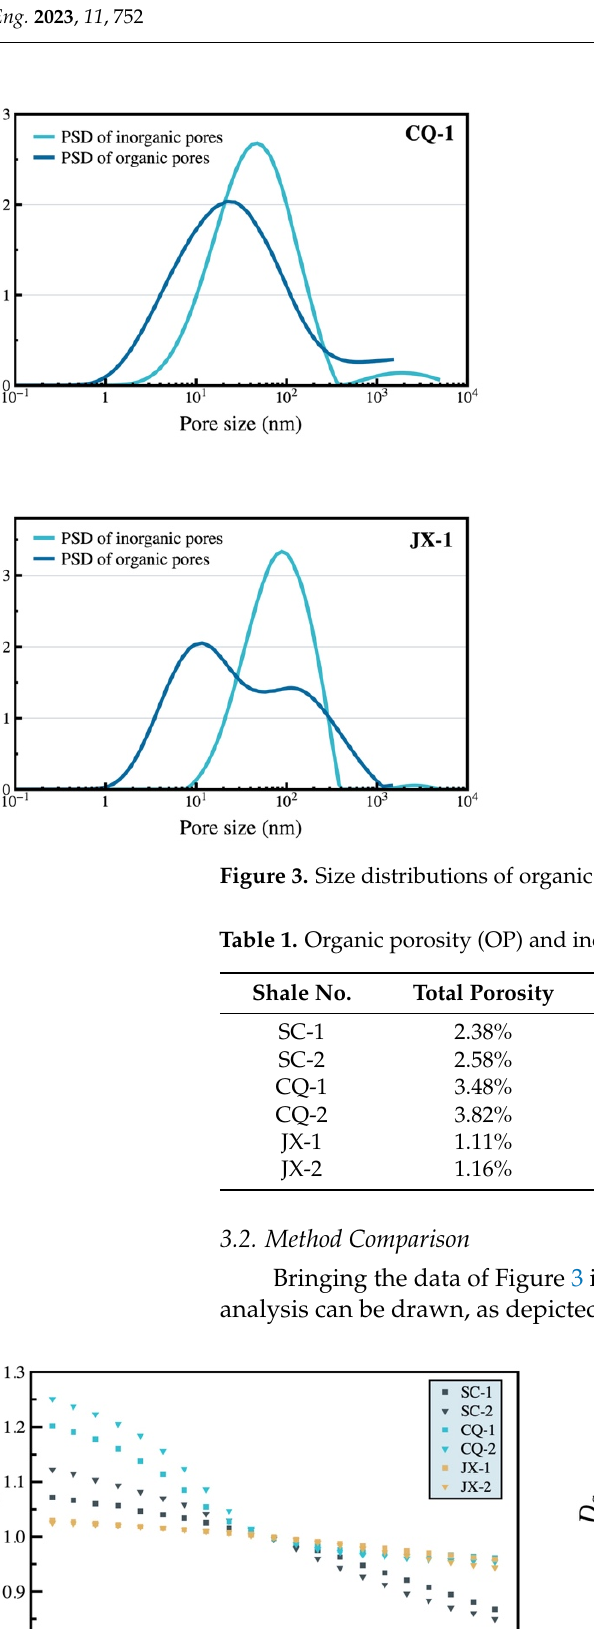
( b ) Figure 5. Multifractal spectra of shale pores: ( a ) organic pores, ( b ) inorganic pores. Figure 4 illustrates the generalized fractal spectra (the relationship between D q and q ) of organic and inorganic shale pores, which describe the multifractal characteristics of pores with di ff erent sizes. D q corresponding to smaller q mainly re fl ects the characteris- tics of seepage pores, while D q corresponding to greater q mainly re fl ects the character- istics of adsorption pores. From Figure 4, it can be seen that D q decreases with 𝑞 for both organic pores and inorganic pores. To comprehensively analyze the generalized fractal spectra, several characteristic parameters were introduced in this study. These parameters include D 0 , D 1 , D 2 , D qmax , D qmin , ∆ D q , D 0 − D 1 and H , where D , D 1 and D 2 repre- sent the generalized dimension when q = 0, 1 and 2, respectively, D qmax and D qmin are the maximum and minimum of D q in the generalized fractal spectrum, ∆ D q = D qmax − D qmin is the main index to re fl ect the heterogeneity of pore distribution in the whole aper- ture range, and H = (1 + D 2 )/2. This is the Hurst index [37–39], which can characterize the pore connectivity [43]. All of the above-mentioned parameters can be directly extracted from the generalized fractal spectra, and their speci fi c values for organic and inorganic shale pores are listed in Tables 2 and 3, respectively. The results show that for both the organic pores and the inorganic pores of the six shale samples, the following relation is available: D 0 > D 1 > D 2 , which means that the structures of the organic and inorganic pores are in accordance with the multifractal characteristics.